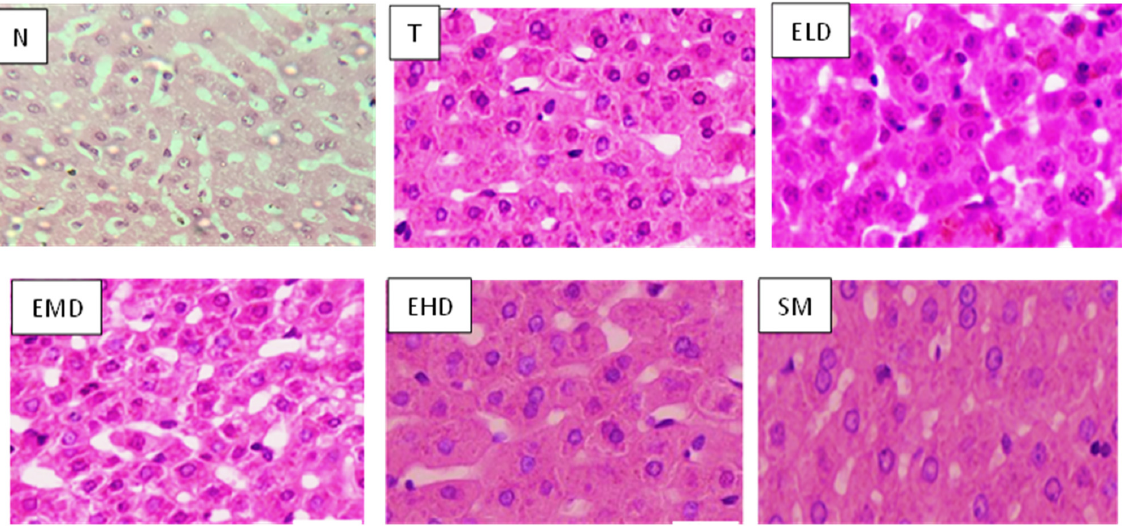
Figure 5. Kidney and liver micrographs of various experimental animal groups, i.e., N = normal, T = toxic, ELD = Extract low dose (100 mg/kg BW), EMD = Extract medium dose (200 mg/kg BW), EHD = Extract high dose (400 mg/kg BW), SM = silymarin (100 mg/kg BW).